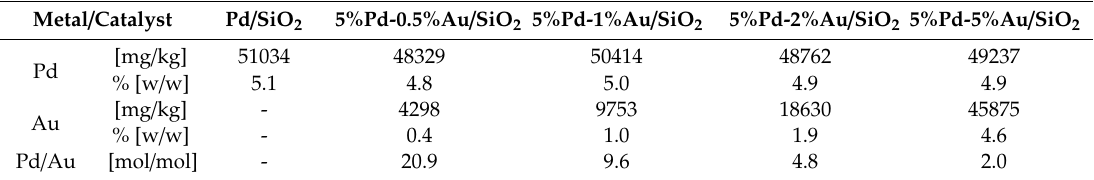
Table 5. The content of Pd and Au in 5%Pd-X%Au / SiO 2 catalysts determined by the AAS technique.